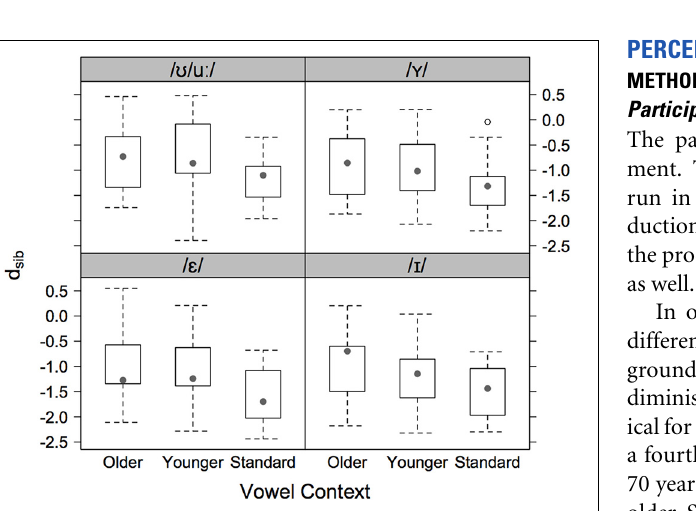
FIGURE 1 | Boxplots of the log. Euclidean distance ratio, d sib for older AG (left), younger AG (center), and SG speakers (right). Negative values indicate productions closer to the /s/-centroid, positive values are productions closer to the /